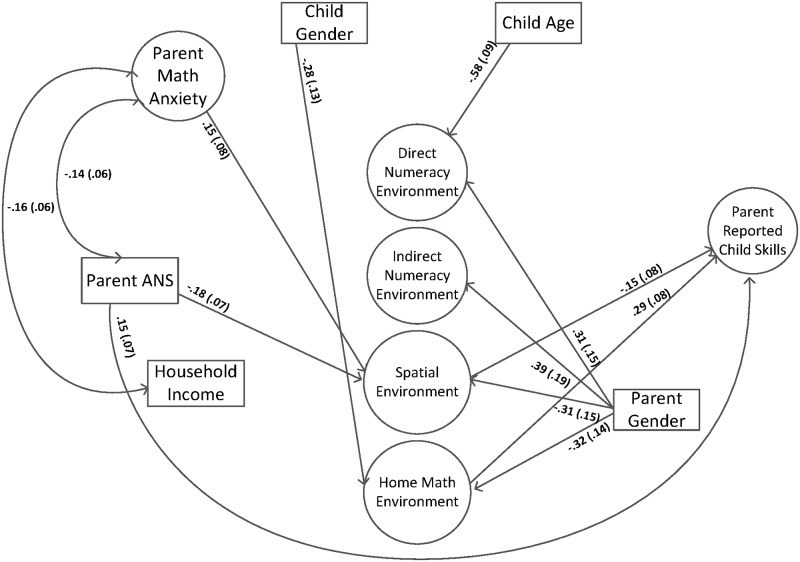
Home math environment factors, household income, parent math anxiety and parent ANS, predicting parent report of child skills.Standard errors are in parentheses. Solid lines and bolded text represent significant pathways, p < .05. Non-significant pathways are not displayed for simplicity.